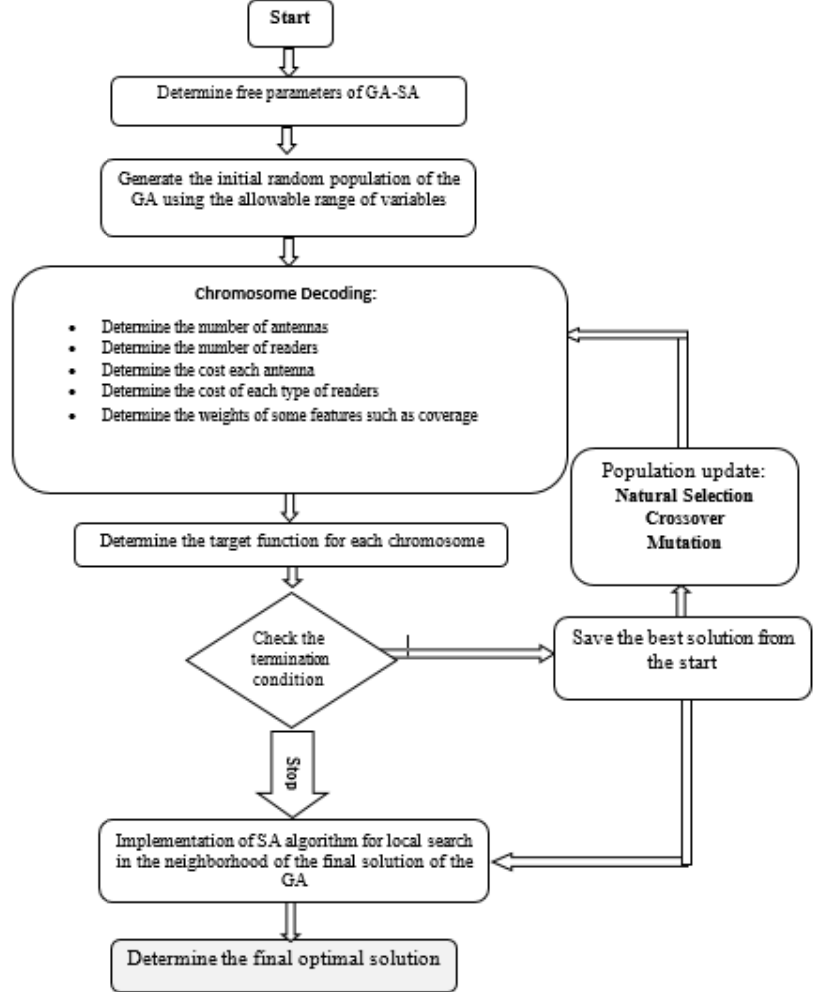
Fig. 7. Overall flowchart of the GA-SA algorithm to optimize the RNP